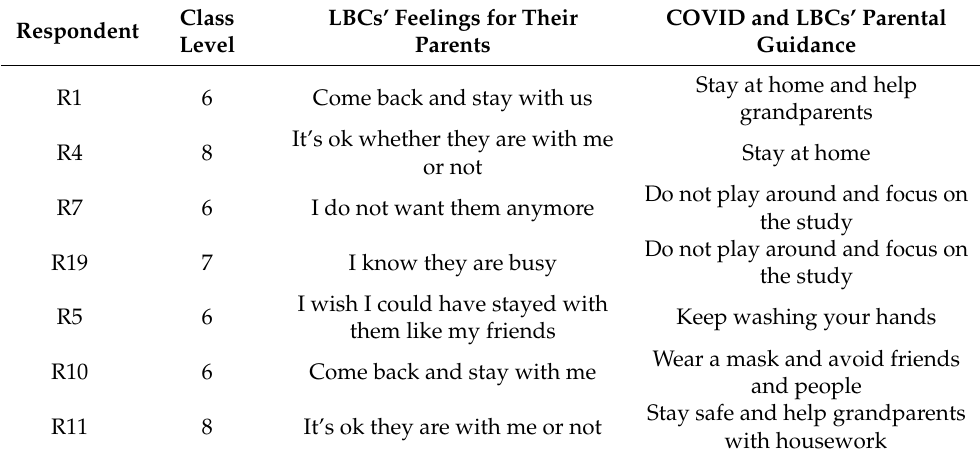
Table 3. LBCs’ view of their migrant